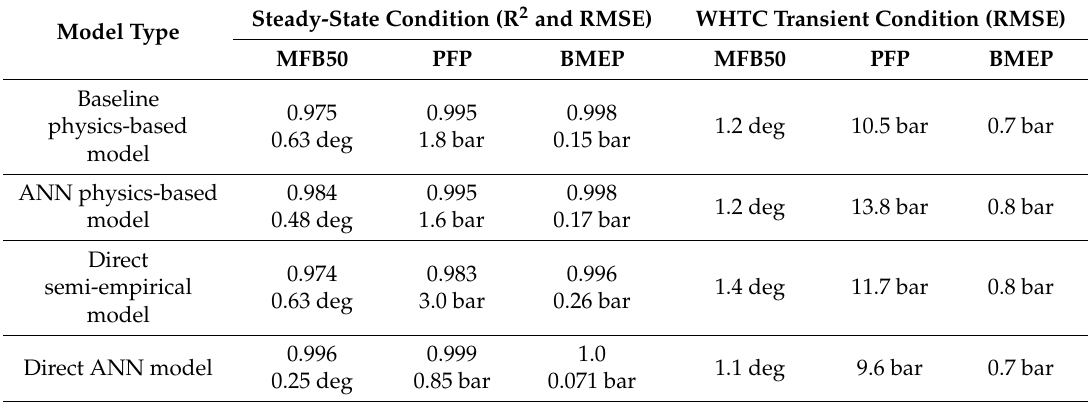
Table 9. Comparison of the performance of the four di ff erent models under steady-state and transient operating